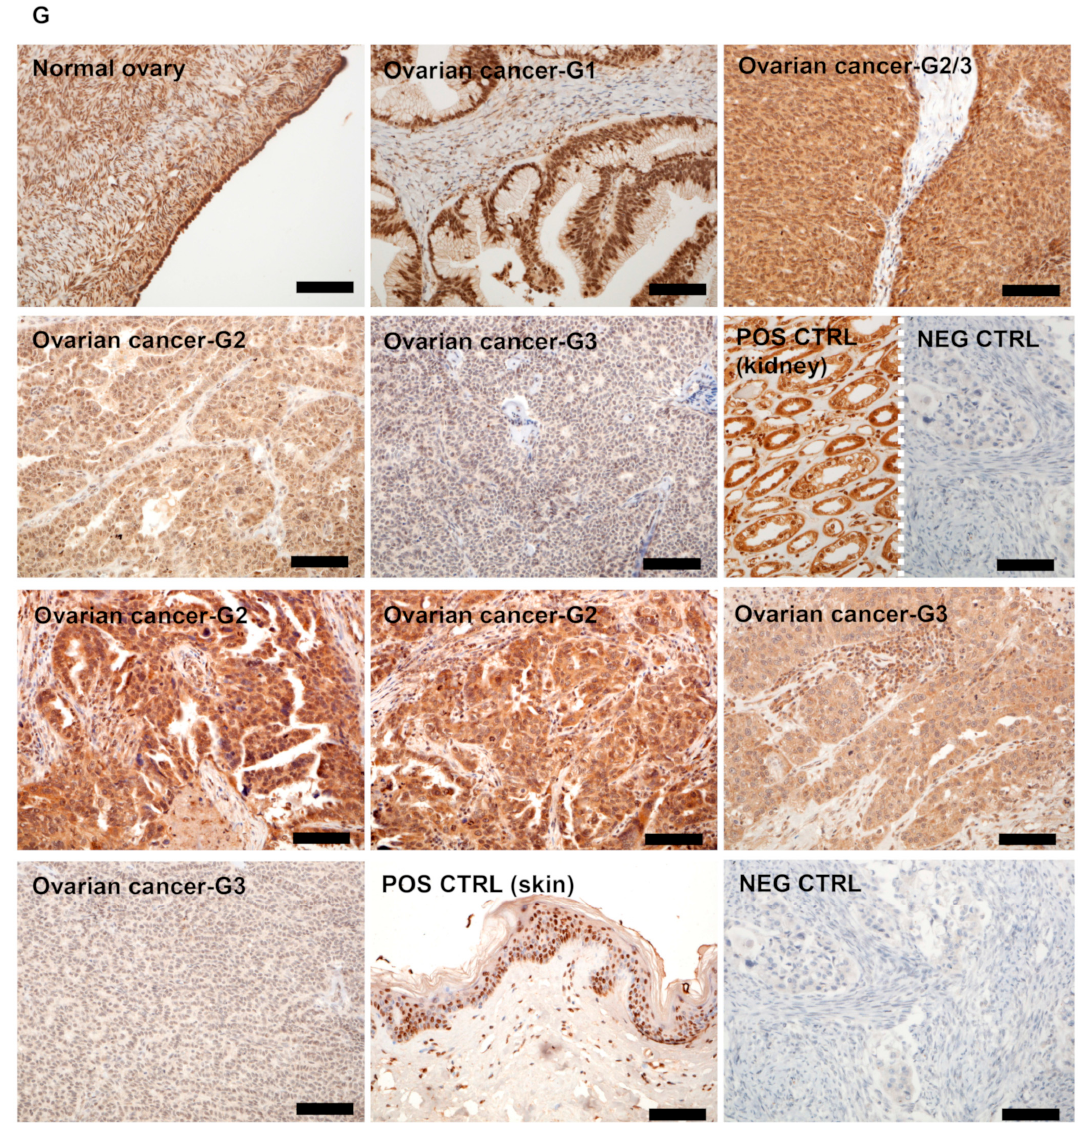
Figure 1. Cytoplasmic and nuclear retinoic acid-related orphan receptor γ and α (ROR γ and ROR α ) immunostaining in normal ovary ( n = 22) and ovarian tumors ( n = 65) ( A , B ), in relation to tumor grade in primary tumors ( C , D ) and in metastatic tumors ( n = 16) ( E , F ). Statistically significant differences are denoted with asterisks as determined by ANOVA (** p < 0.01, and *** p < 0.001). ( G ) Representative ROR γ immunostaining in normal epithelia, ovarian cancers, and positive (POS CTRL) and negative (NEG CTRL) controls. Scale bars = 50 μ m.